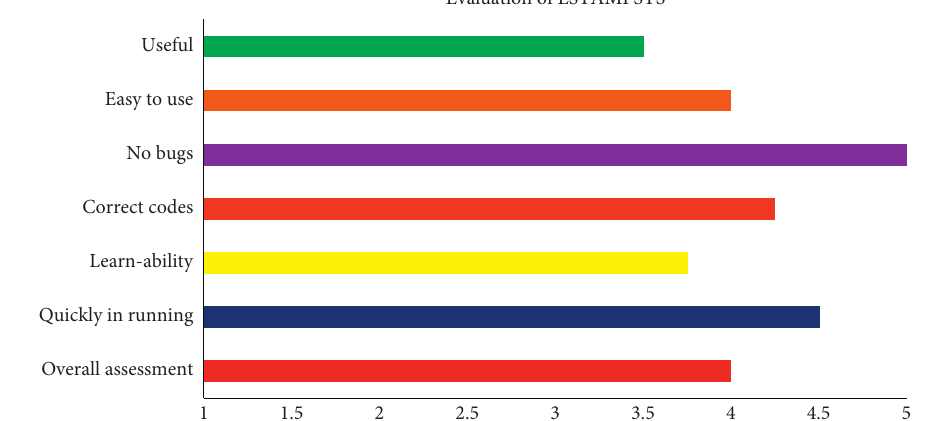
Figure 12: Result of ESTAMPSYS evaluation.